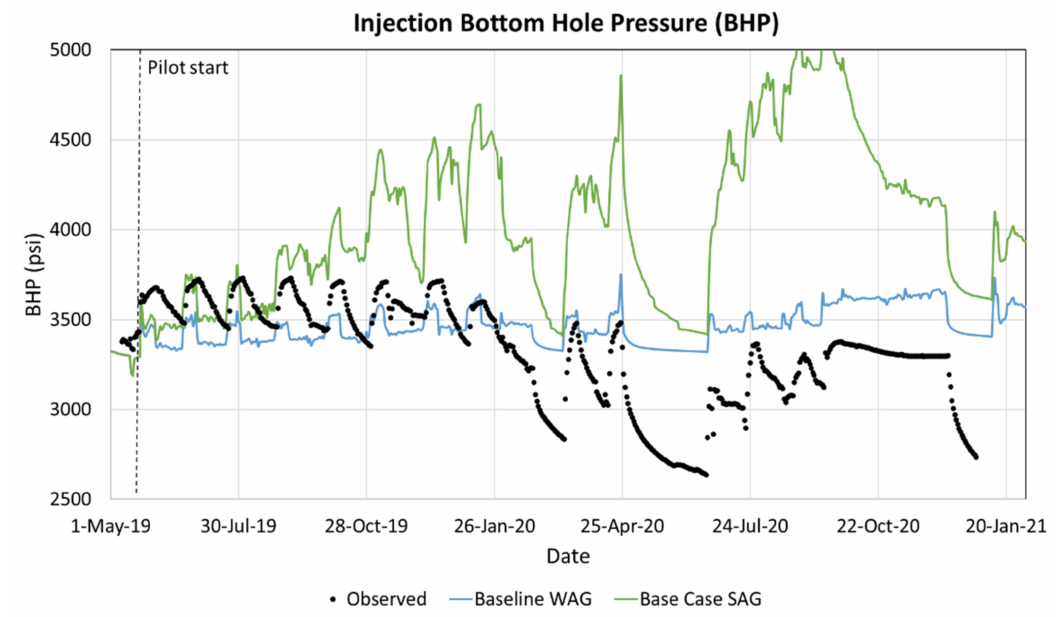
Figure 9. Injection bottom hole pressure (BHP) through time for the baseline WAG (blue curve) and the base case SAG (green curve). The observed BHP is shown as the black